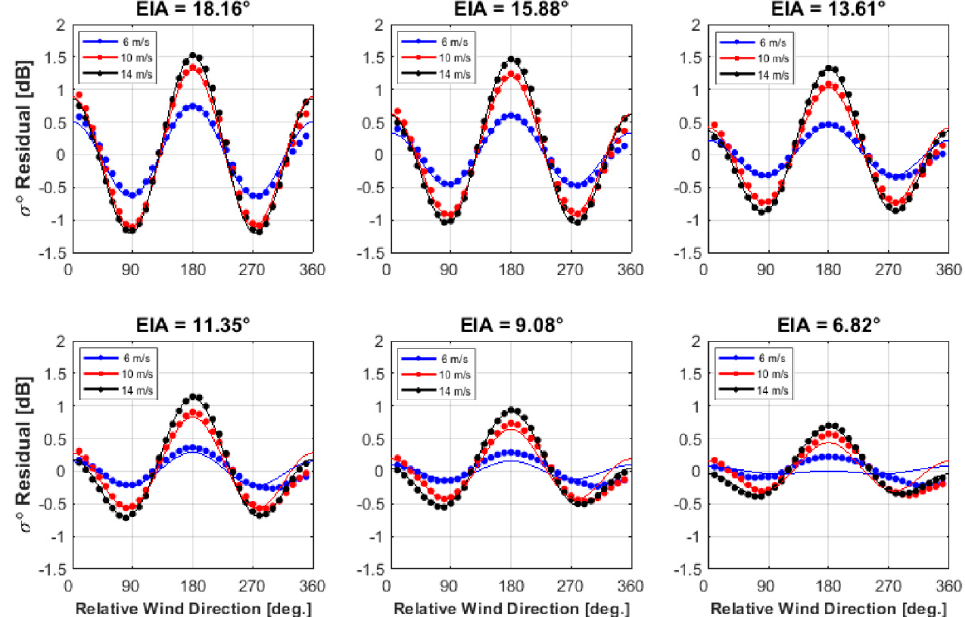
Figure 14. KaPR σ 0 directional anisotropy (in dB) as a function of relative wind direction ( χ ), for three different WS values: 6 m/s (blue), 10 m/s (red), and 14 m/s (black) at different earth incidence angles. The symbols are bin average while the solid lines represent their second-order Fourier fits.